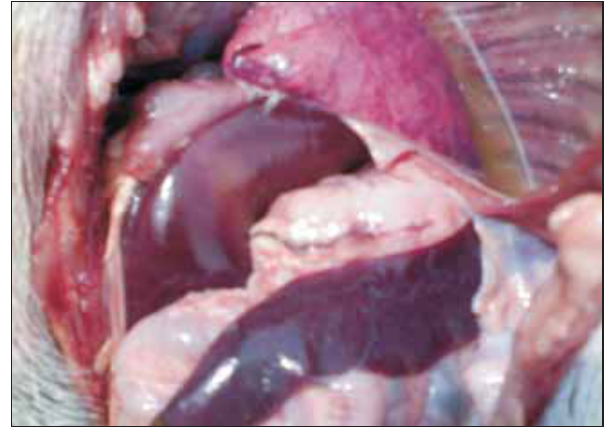
Figure-1: The photograph showing a case of oedematous swelling in the pharyngeal and ventral cervical region and brisket of adult Hampshire crossbred pig and subsequent scratch wound.